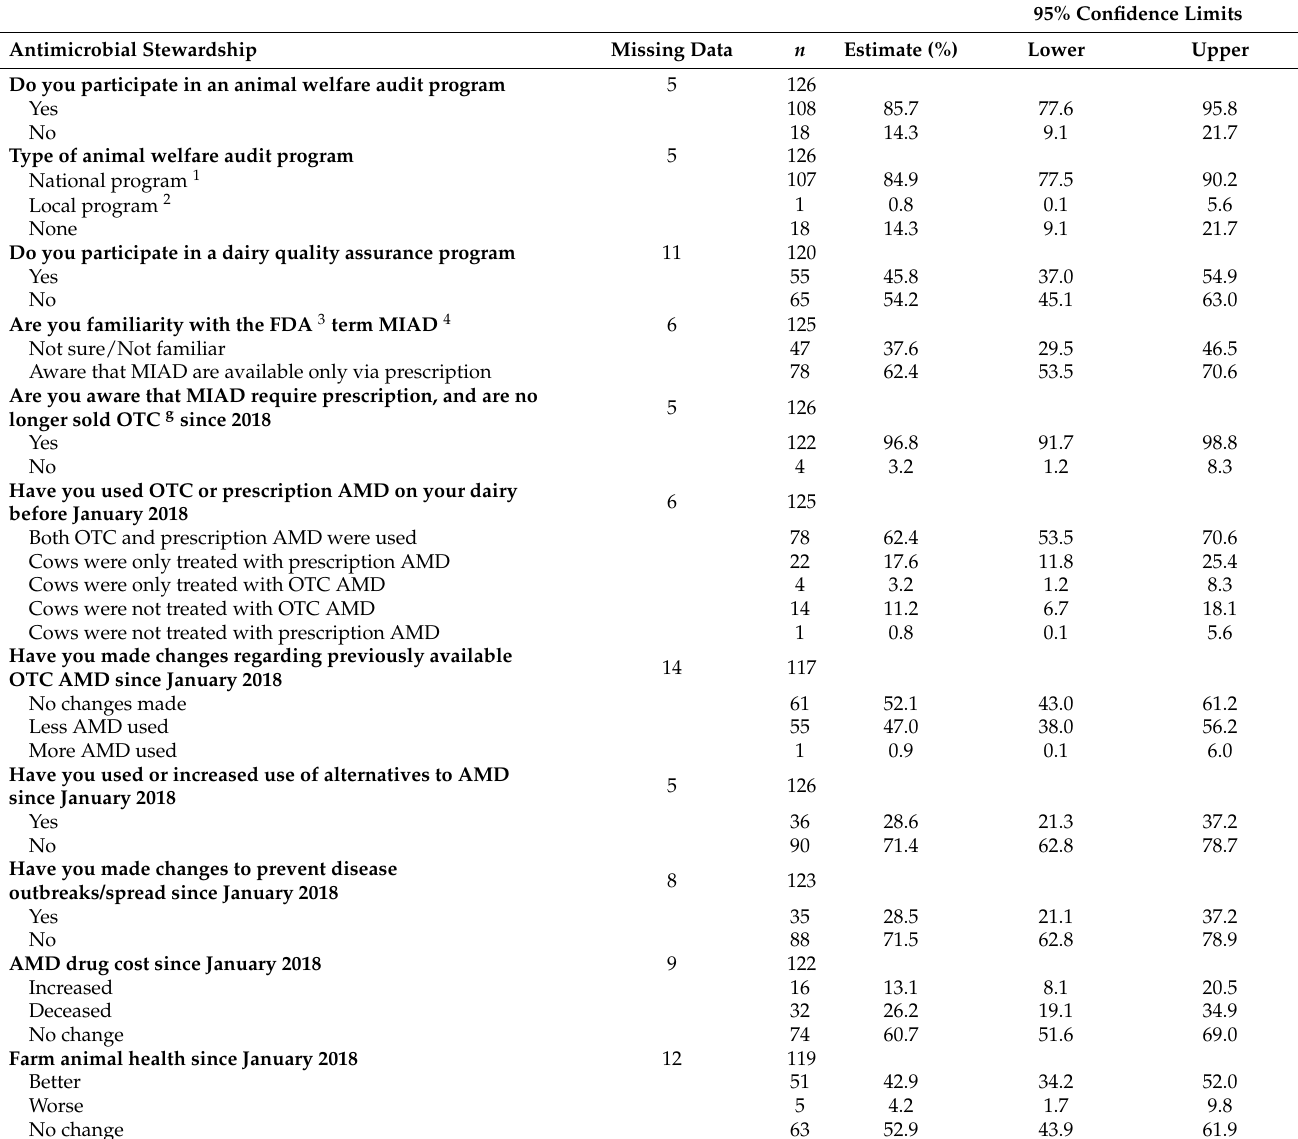
Table 7. Summary of practices and perspectives from responses to questionnaire on antimicrobial drug (AMD) use in adult cows on California dairies during